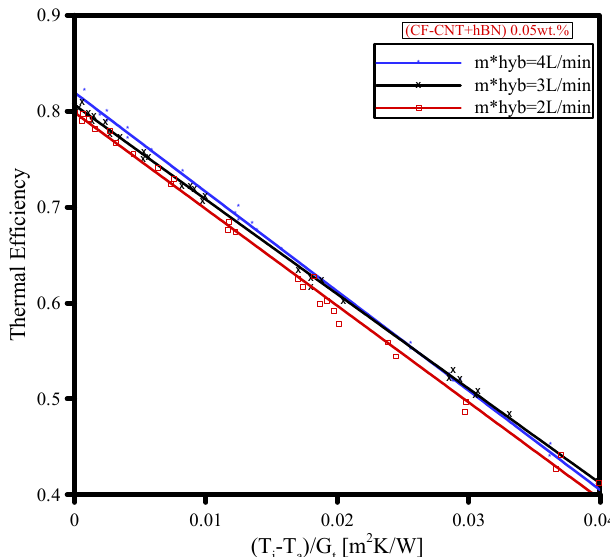
Figure 14. Comparison of thermal efficiency of the 0.05 wt.% water-based nanofluid for various mass flow values.